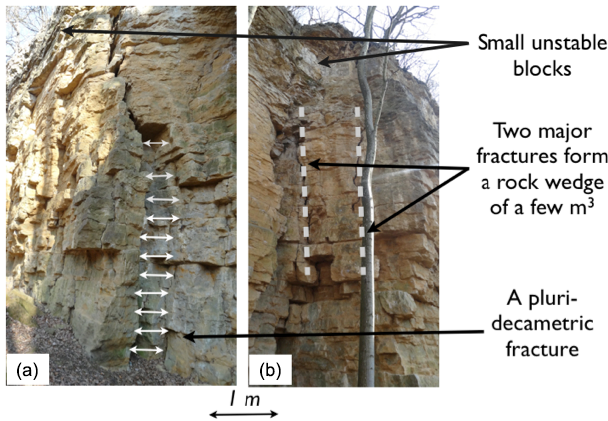
Figure 1. Sector 1 (a) and sector 2 (b) and their main characteristics (Delonca et al., 2013).